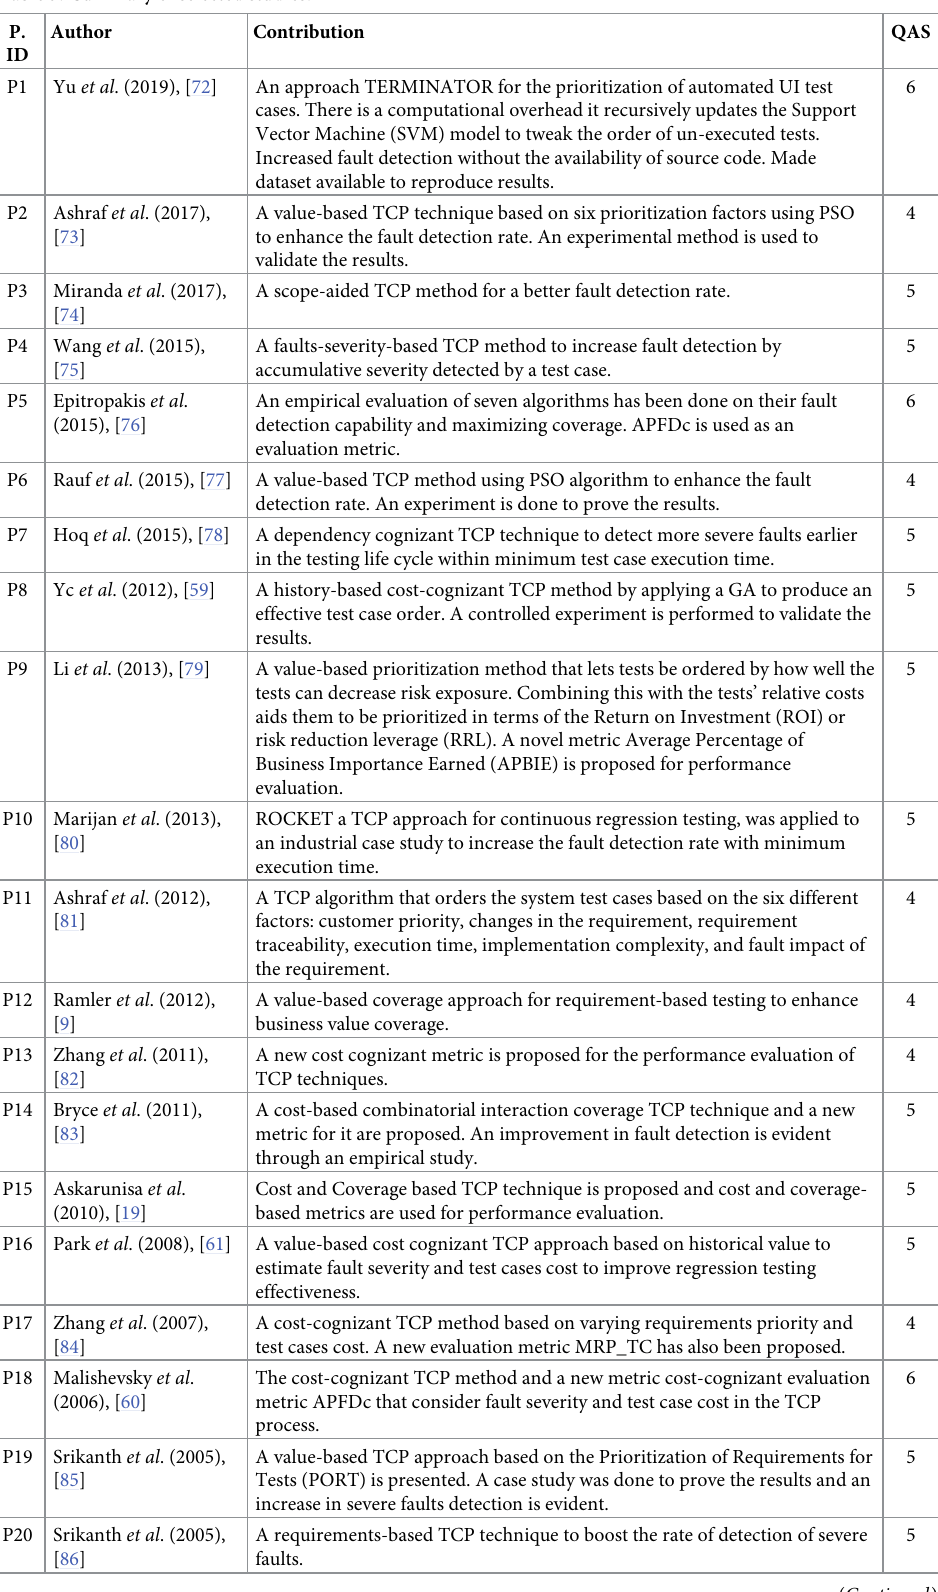
Table 5. Summary of selected